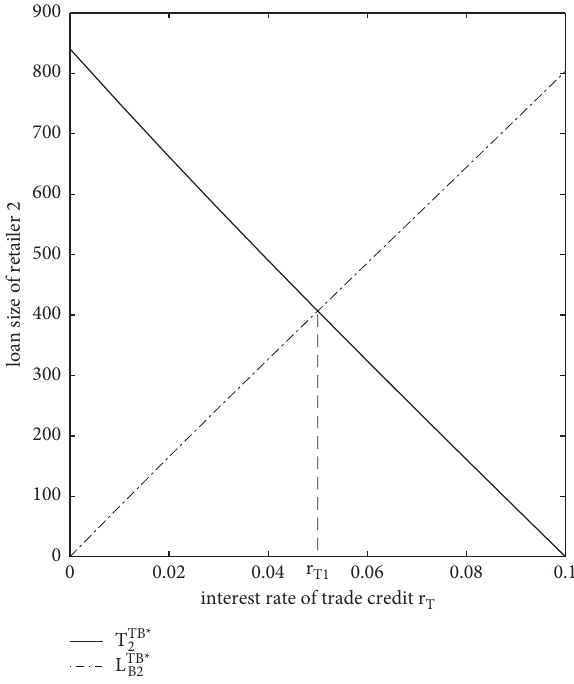
Figure 24: Loan size allocation of retailer